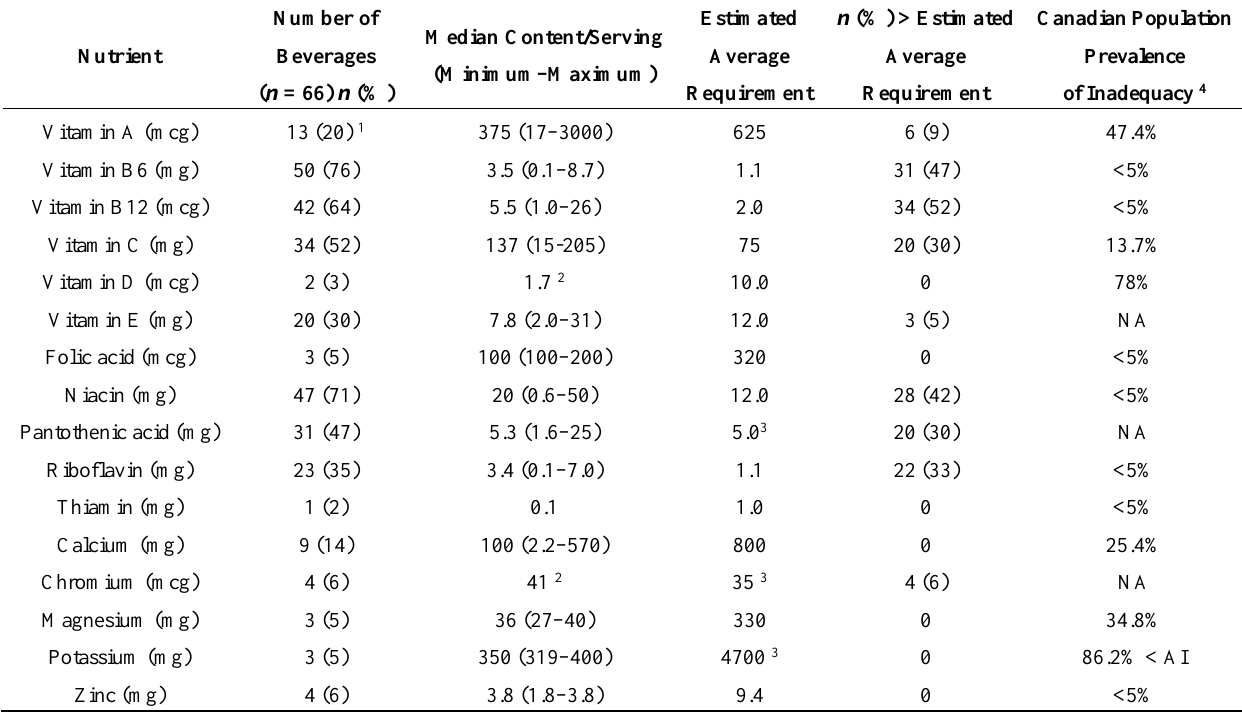
Table 1. Nutrient content of ‘novel’ beverages per serving in relation to nutrient requirements and estimated prevalence of inadequacy for Canadian men, 19–30